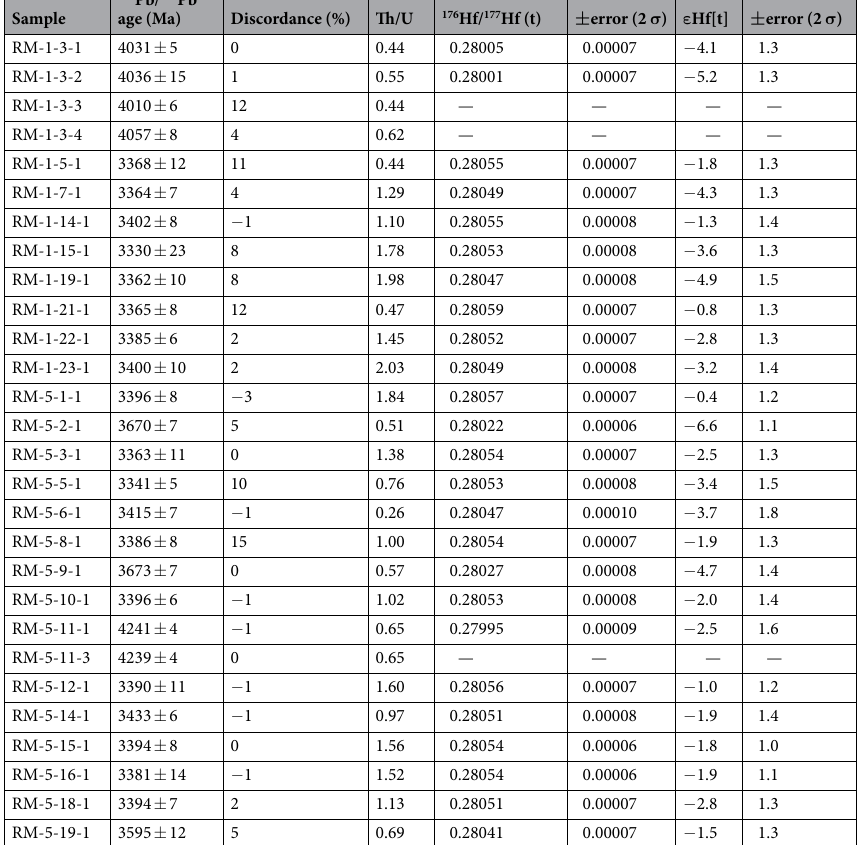
Table 1. Selected SHRIMP U-Pb and Lu-Hf isotopic data for samples RM-1 and 5 (OMTG). * 176 Hf/ 177 Hf (t) denote initial isotopic ratios calculated using 207 Pb/ 206 Pb ages (Ma) of respective spots in zircons. 207 Pb/ 206 Pb age data (Ma) with ≤ 10% discordance are presented (including 4 spots with > 10% discordance but consistent 176 Hf/ 177 Hf (t) values), whereas all data are presented in Supplementary dataset SF1 and